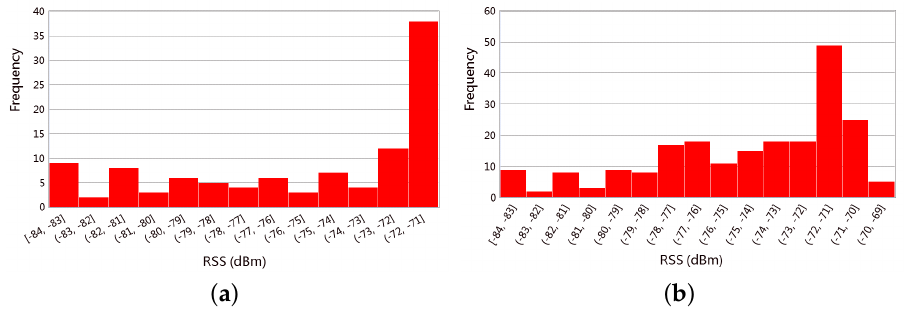
Figure 15. RSSI Histogram of two BLE beacons: ( a ) Beacon ’AC:23:3F:20:8D:67’; and ( b ) Beacon ’AC:23:3F:20:8D:69’.